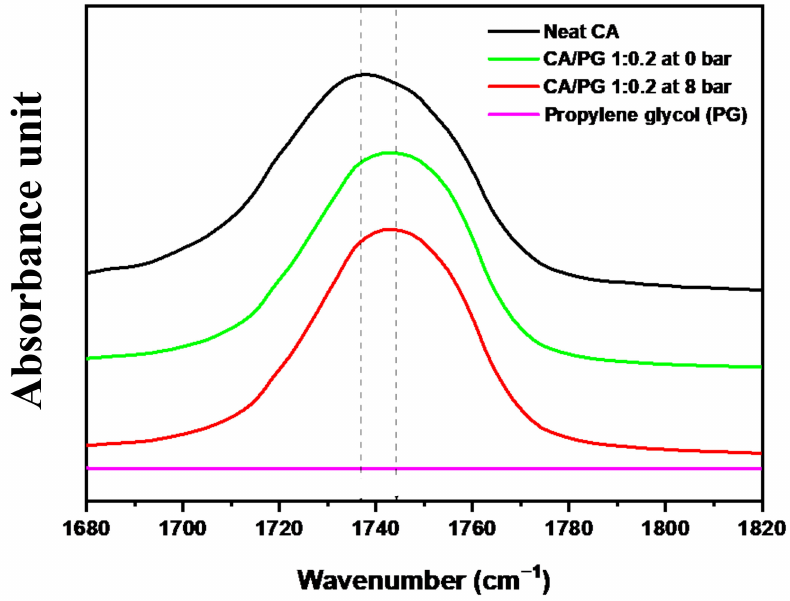
Figure 3. FTIR spectra showing the carbonyl group peaks of the neat CA, 1:0.2 CA/propylene glycol (0 bar, 8 bar) and propylene glycol.